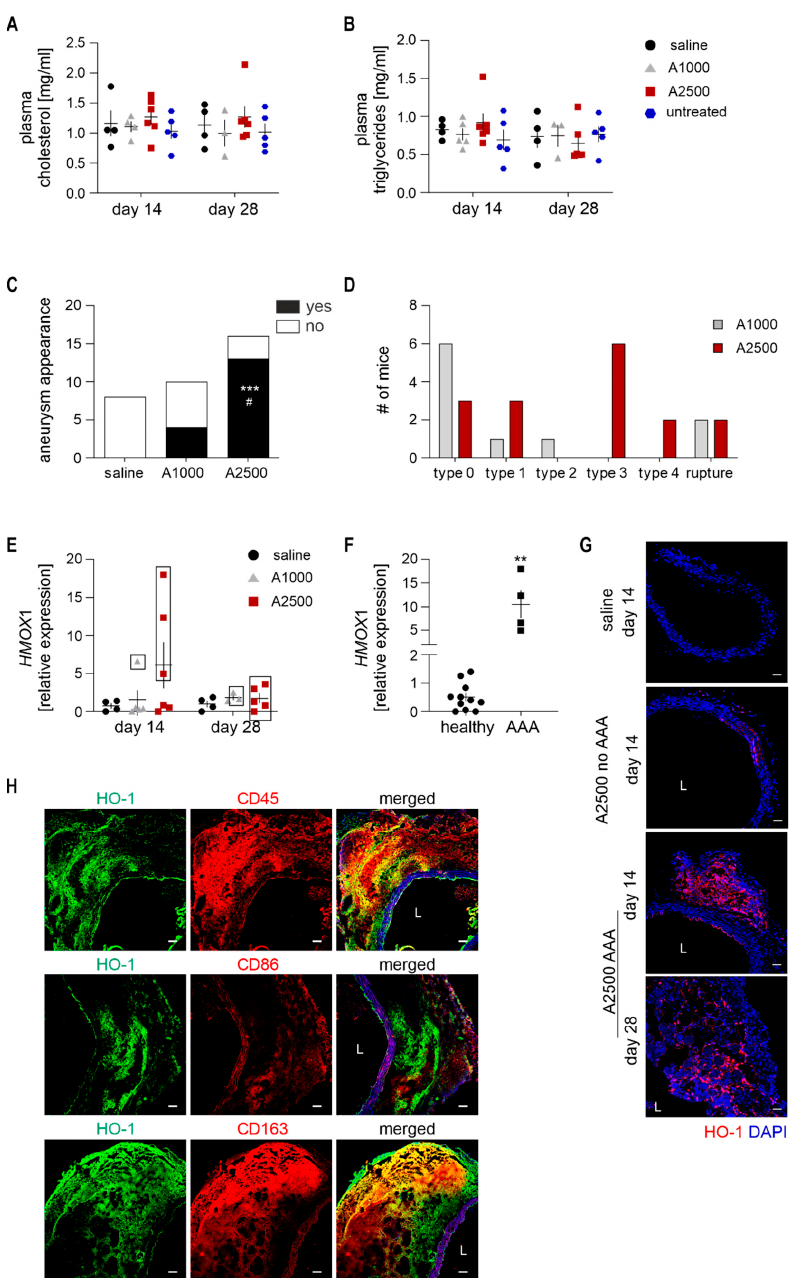
Figure 1. Heme oxygenase 1 is upregulated during the angiotensin II-induced formation of abdominal aortic aneurysm (AAA) in non-hypercholesterolemic mice. The mice were infused with either saline or angiotensin II at the dose 1000 or 2500 ng/kg/min using the osmotic pumps for up to 28 days, as shown in Supplementary Figure S1. ( A ) Plasma cholesterol level assessment in comparison to untreated animals; three-way ANOVA+Tukey’s; ( B ) Plasma triglycerides level assessment in relation with untreated animals; three-way ANOVA+Tukey’s post hoc; ( C ) The frequency of aortic aneurysm appearance. Fisher’s exact test, *** p < 0.001 vs. saline; # p < 0.05 vs. A1000; ( D ) Grading of developed aneurysms. The detailed criteria are presented in the methods section; ( E ) Relative expression of HMOX-1 in the abdominal aortic wall at day 14 and 28 after initiation of AngII infusion. eEF2 was used as a reference gene. Two-way ANOVA with Tukey’s post hoc test. Rectangle—mice, which developed an aneurysm; ( F ) Comparison of the relative expression of HMOX-1 in the abdominal aortic wall at day 14 in mice with and without AAA. eEF2 was used as a reference gene. Mann–Whitney test, ** p < 0.01 AAA vs. no AAA; ( G ) Immunofluorescent staining of HO-1 in the aorta. Red—HO-1; blue—DAPI; L—lumen. Representative images; scale bar 50 µ m; ( H ) Immunofluorescent co-staining of HO-1 and immune cell markers (CD45, CD86, CD163) in the aneurysmal tissue. Green—HO-1, red-CD45/CD86/CD163, blue—DAPI; L—lumen. Representative images, scale bar 50 µ